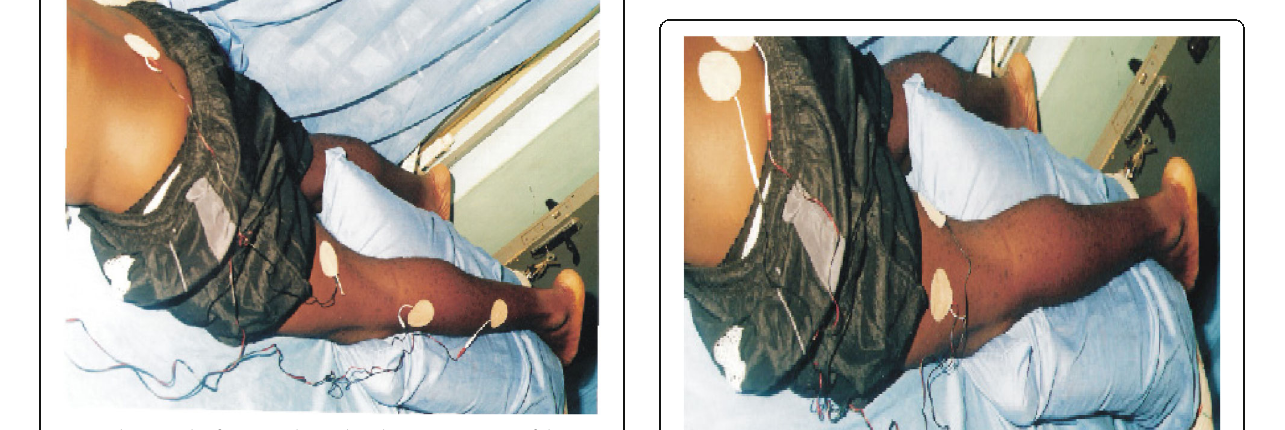
Fig. 1 Showing the first tens electrodes placement on one of the subjects. The electrode was placed in such a way to cover the area of pain perception. From the sciatic nerve root origin down the route of sciatic nerve during a treatment session, in this position treatment lasted 20min and electrodes changed to reflect the position in Fig. 2